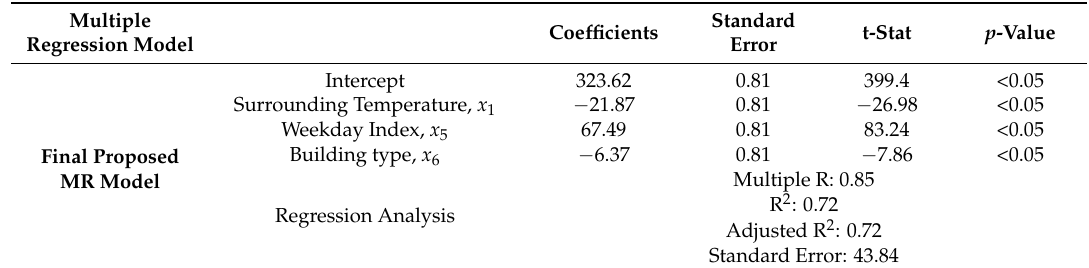
Table 6. Proposed MR Model for Administration and Academic